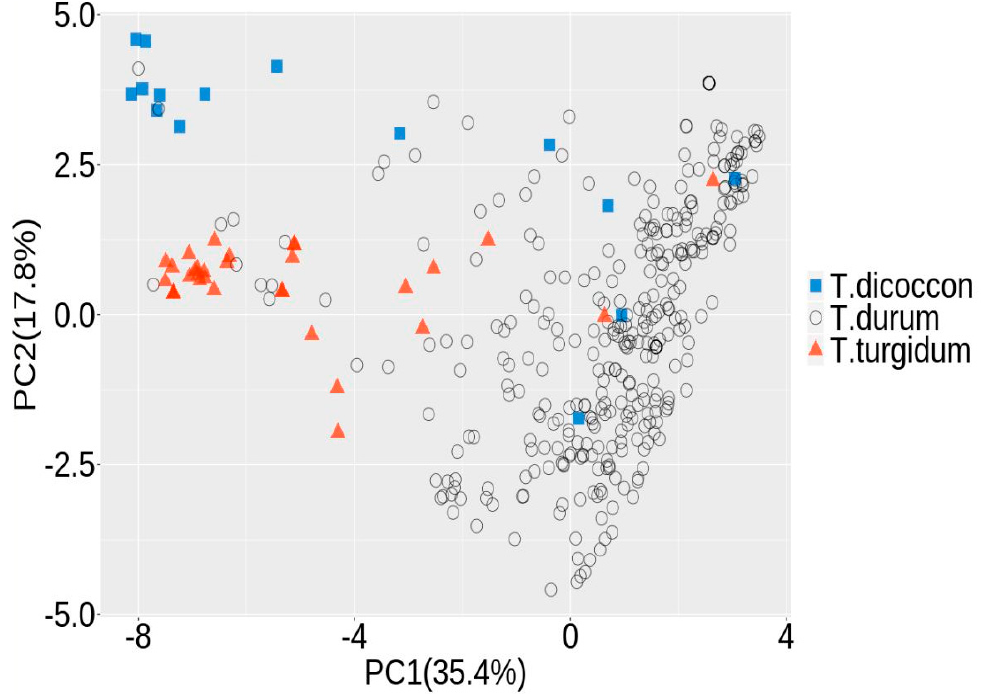
Figure 3. Scatterplot of accession distribution based on the first two principal components (PC1, PC2), labelled by species.